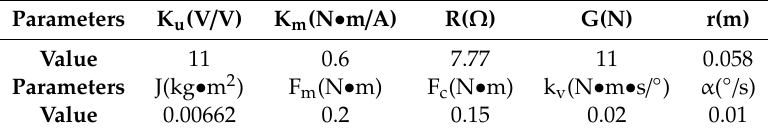
Table 6. System parameters.